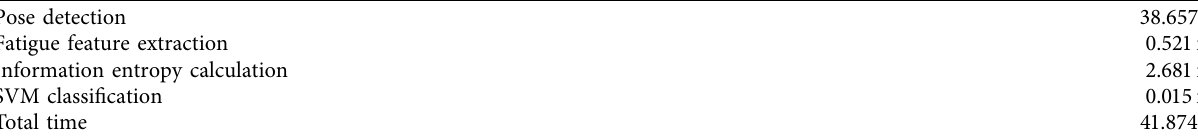
Table 3: The time statistics of the proposed DFD method.